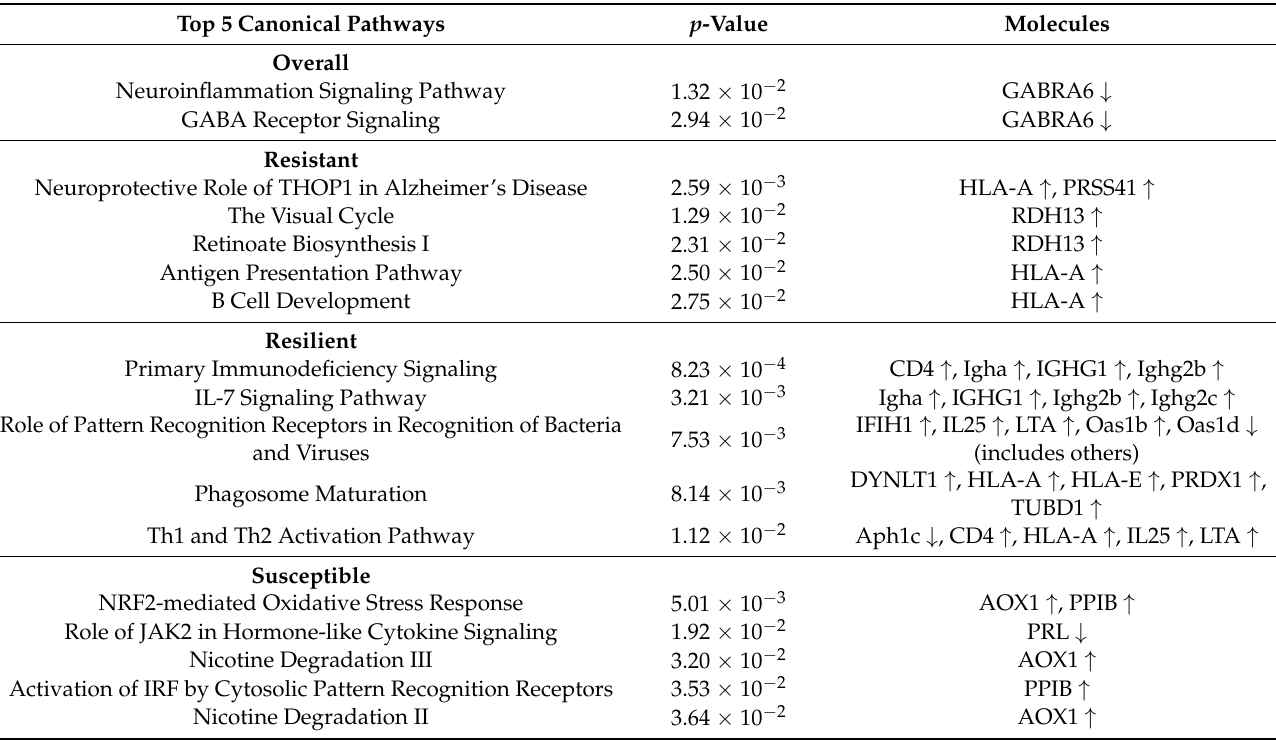
Table 1. Top 5 canonical pathways for categories described in this study, along with their respective p -values [28], and the key molecules (genes or complexes) involved in these pathways. Arrows indicate the direction of gene expression (increased or decreased) in infected versus uninfected mice, based on the averaged expression values for strains included in each response. Additional information for these molecules, including descriptions and strain-specific expression, is available in Supplementary Table